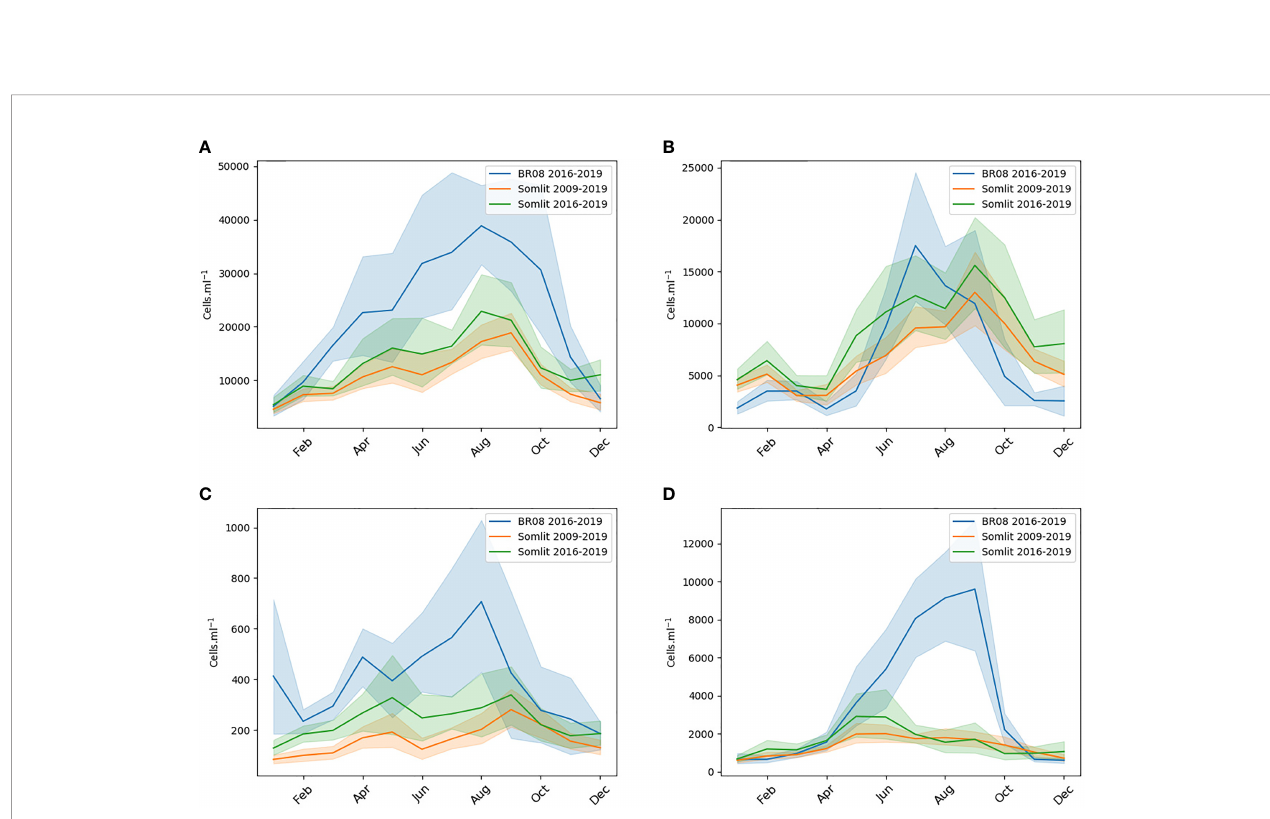
FIGURE 4 | Microphytoplankton images recorded during daylight high water at the IFC moored in the Daoulas estuary on 29 th June (A) and on 9 th July 2019 (B) .